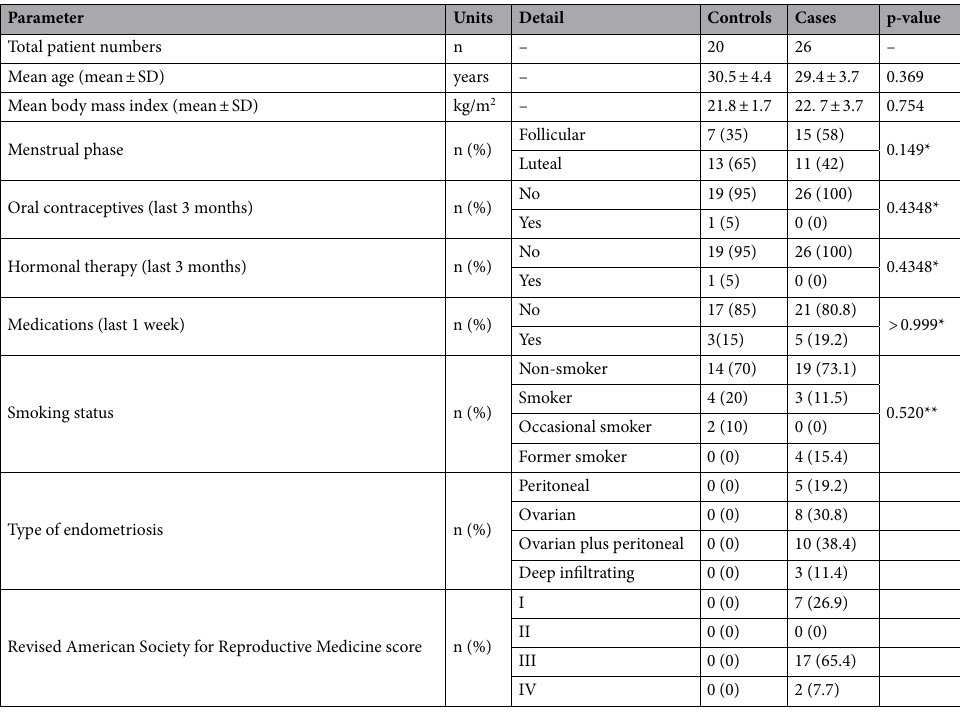
Table 2. Clinical characteristics of the 46 patients included in the validation phase. *Fisher’s exact test. **Chi- square test for